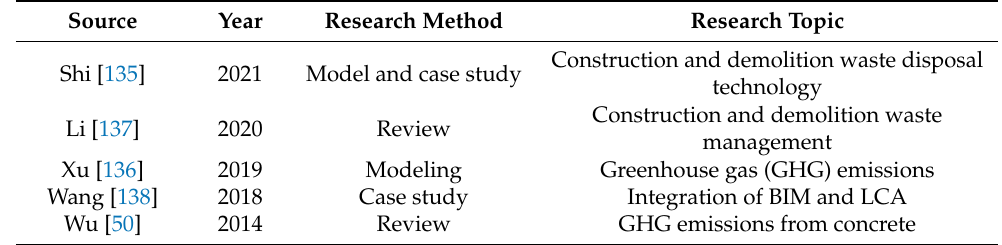
Table 5. The role of BIM in the demolition stage in terms of carbon emissions (generated by the